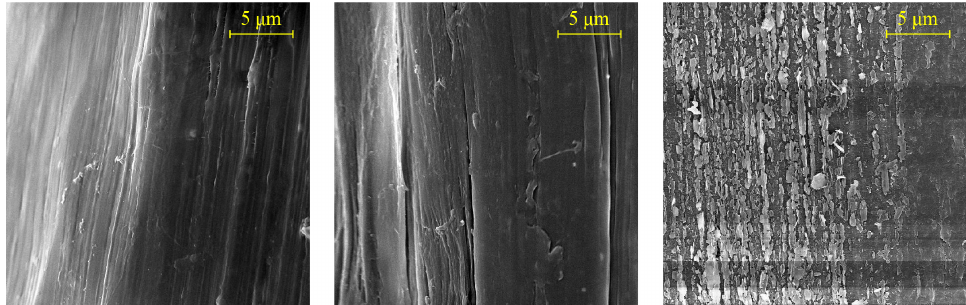
Figure 3. SEM images of reference (left), 30 s (middle) and 480 s (right) plasma treated Concrix fibers.